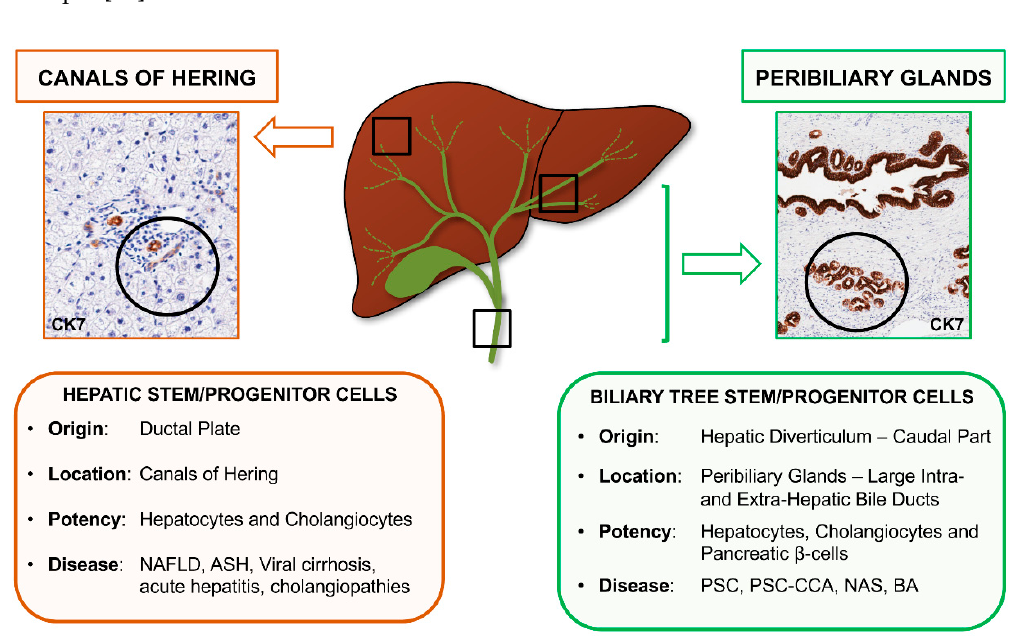
Figure 1. Stem/progenitor cell niches in the human biliary tree. Canals of Hering harbor Hepatic Stem/progenitor Cells (HpSCs), while peribiliary glands (PBGs) constitute the niche for Biliary Tree Stem/progenitor Cells (BTSCs). Embryological origin, location, potency, and diseases in which cells are involved are summarized in the boxes. CK7: cytokeratin 7; NAFLD: Non-alcoholic fatty liver disease; ASH: Alcoholic steatohepatitis; PSC: Primary sclerosing cholangitis, CCA: cholangiocarcinoma; NAS: non-anastomotic strictures; BA: biliary atresia. Original Magnification: 10 × (left) and 5 × (right).